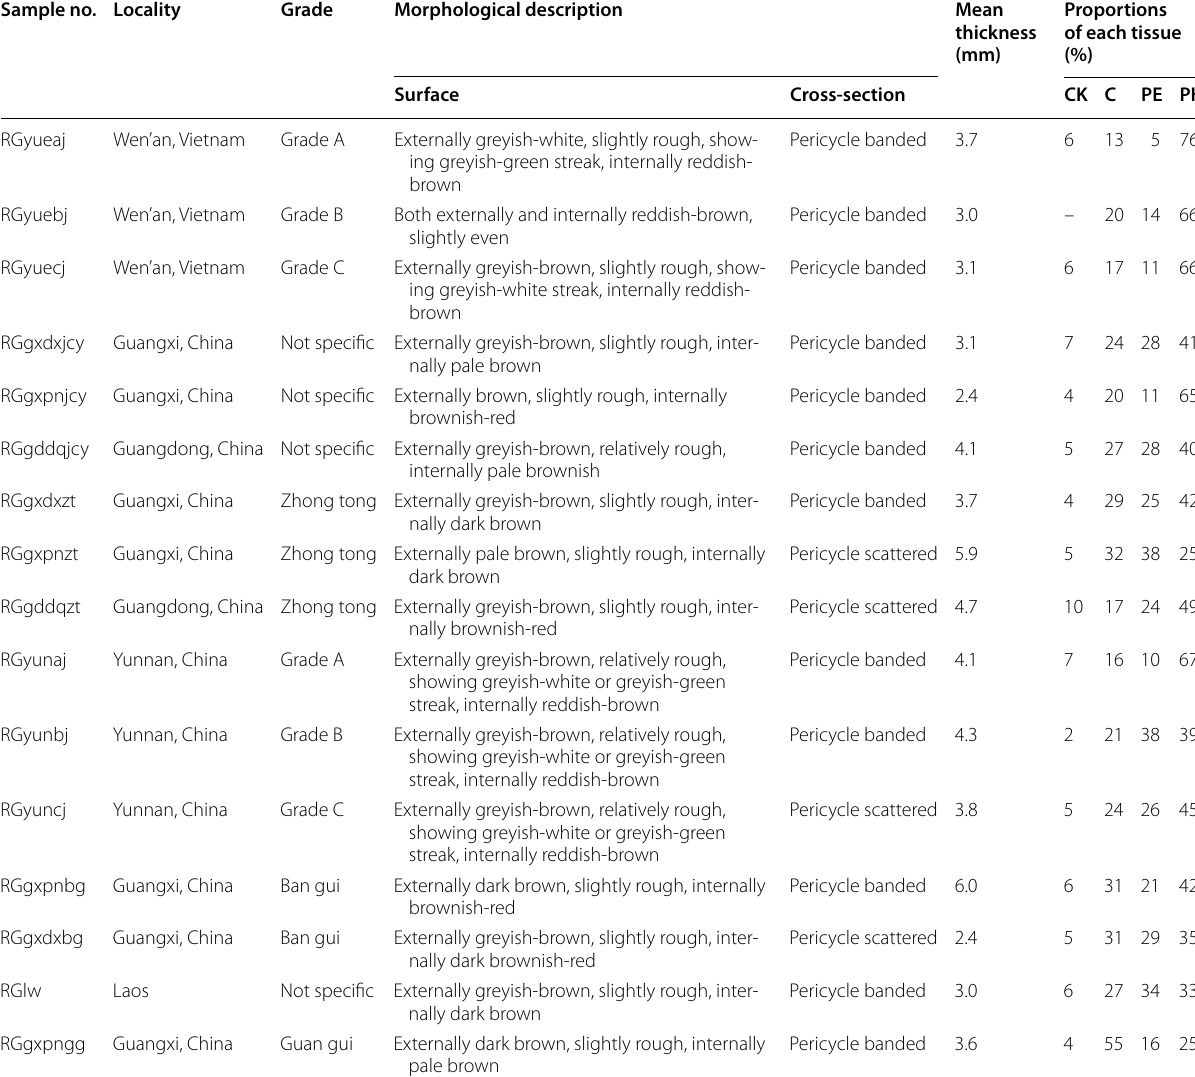
Table 1 Sample information of Cinnamomum cassia materials Sample no.